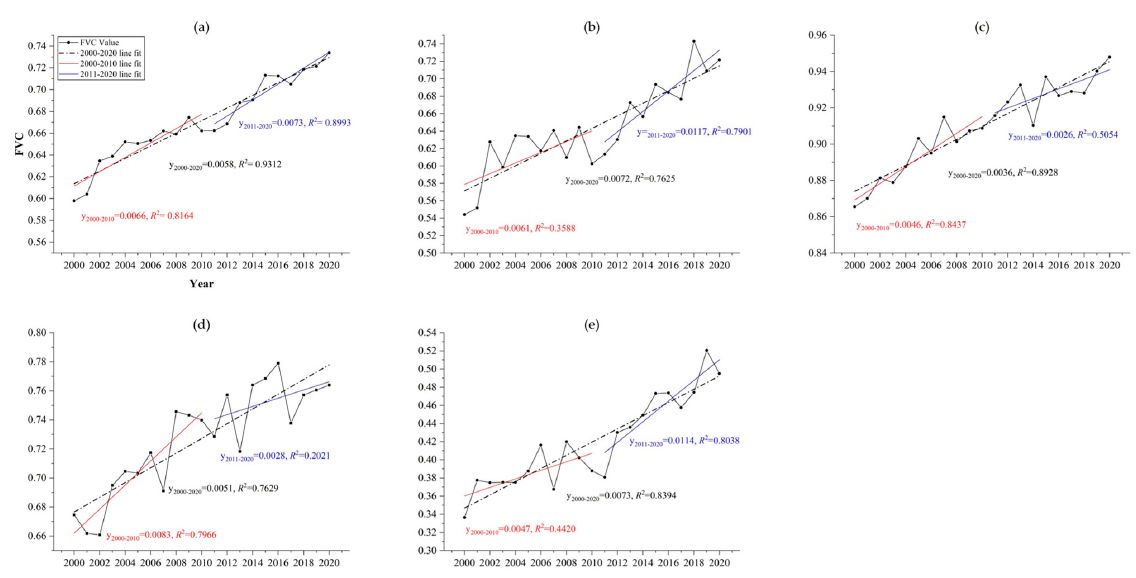
Figure 3. Change of FVC average value in the QBM from 2000–2020. ( a ) Year; ( b ) Spring; ( c ) Summer; ( d ) Autumn; ( e ) Winter.